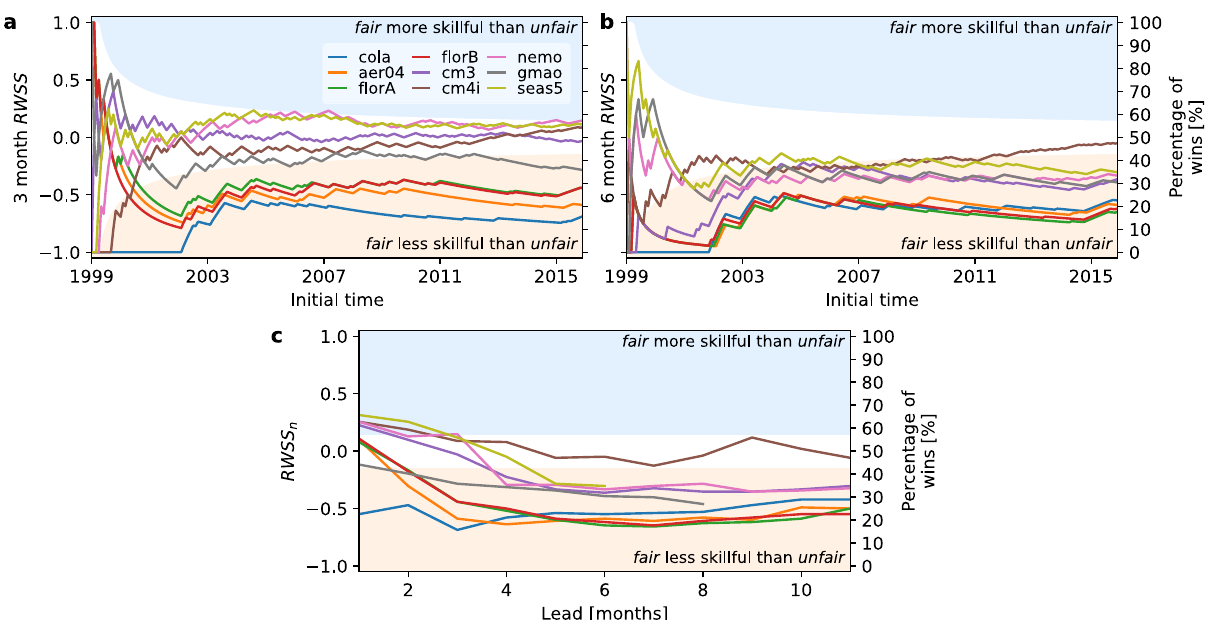
Fig. 3 Comparison of El Niño Southern Oscillation (ENSO) skill for fair and unfair methods. Random walk skill score ( RWSS ) for lead 3 ( a ), lead 6 ( b ), and RWSS n as a function of lead time ( c